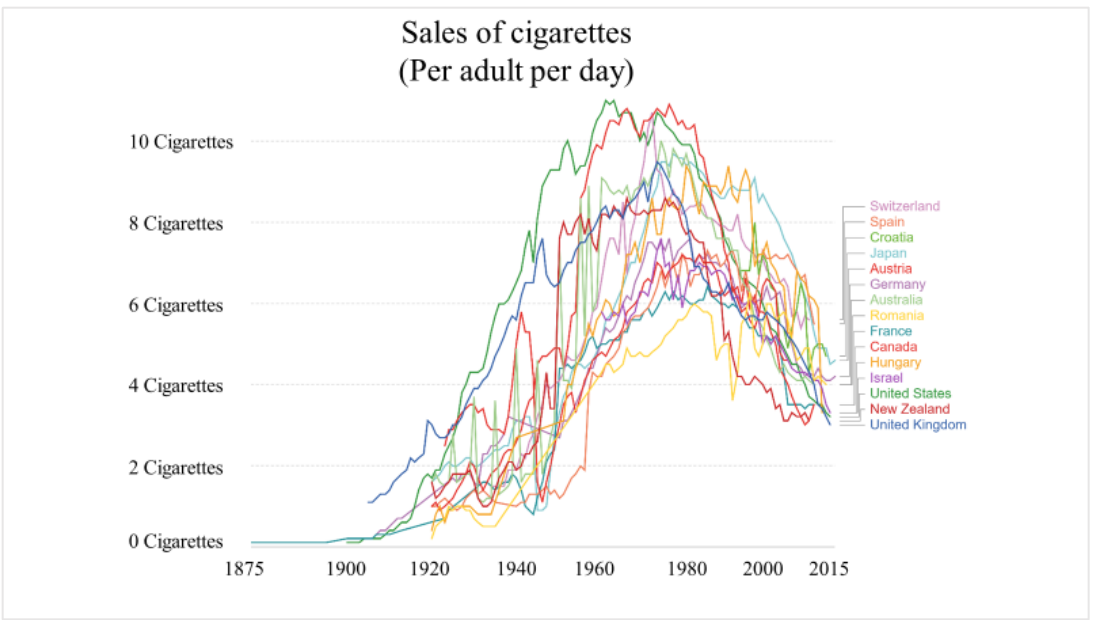
Figure 2. Sales of cigarettes in some of the countries of the world [1,2,4].